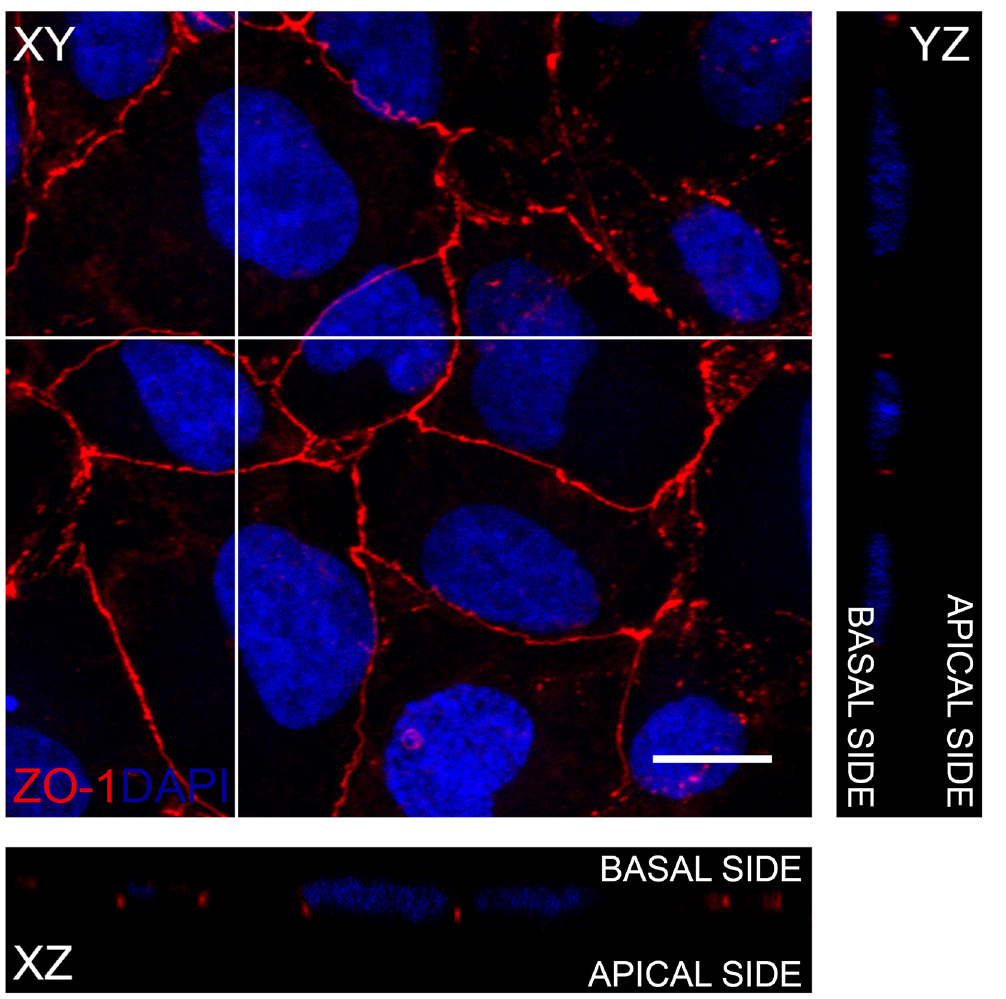
Fig 4. Polarization of the ARPE-19 monolayer. Z-projections (XZ and YZ) from apical side to basal side and maximum intensity projection of the XY plane in the ARPE-19 monolayer represent the localization of Zonula Occludens (ZO-1, red) in the confocal micrograph after immunofluorescence labeling with the nuclear label 4 ’ ,6-diamidino-2-phenylindole (DAPI, blue). Scale bar is 10 μ m.